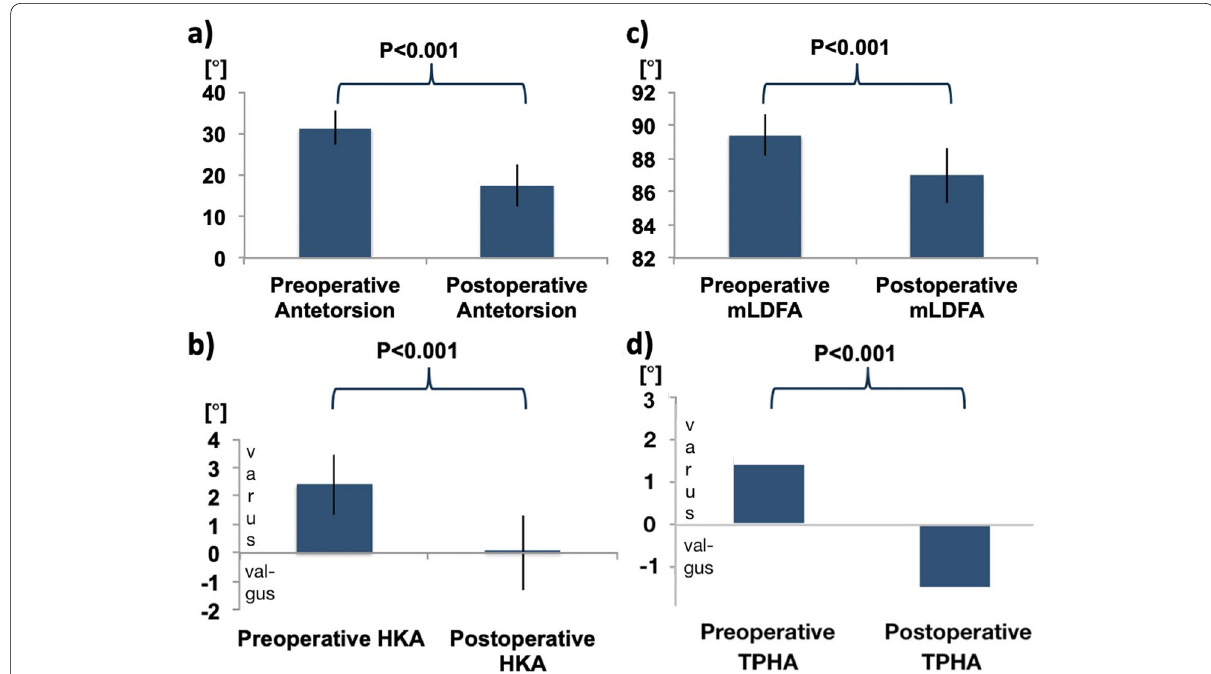
Fig. 5 Supracondylar external rotation osteotomy of the femur: radiographic measures pre‑ and postoperatively. a Femoral antetorsion. b HKA. c mLDFA. d TPHA. HKA: Hip Knee Ankle angle, mLDFA: Mechanical lateral distal femoral angle, TPHA: Tibia plafond horizontal orientation